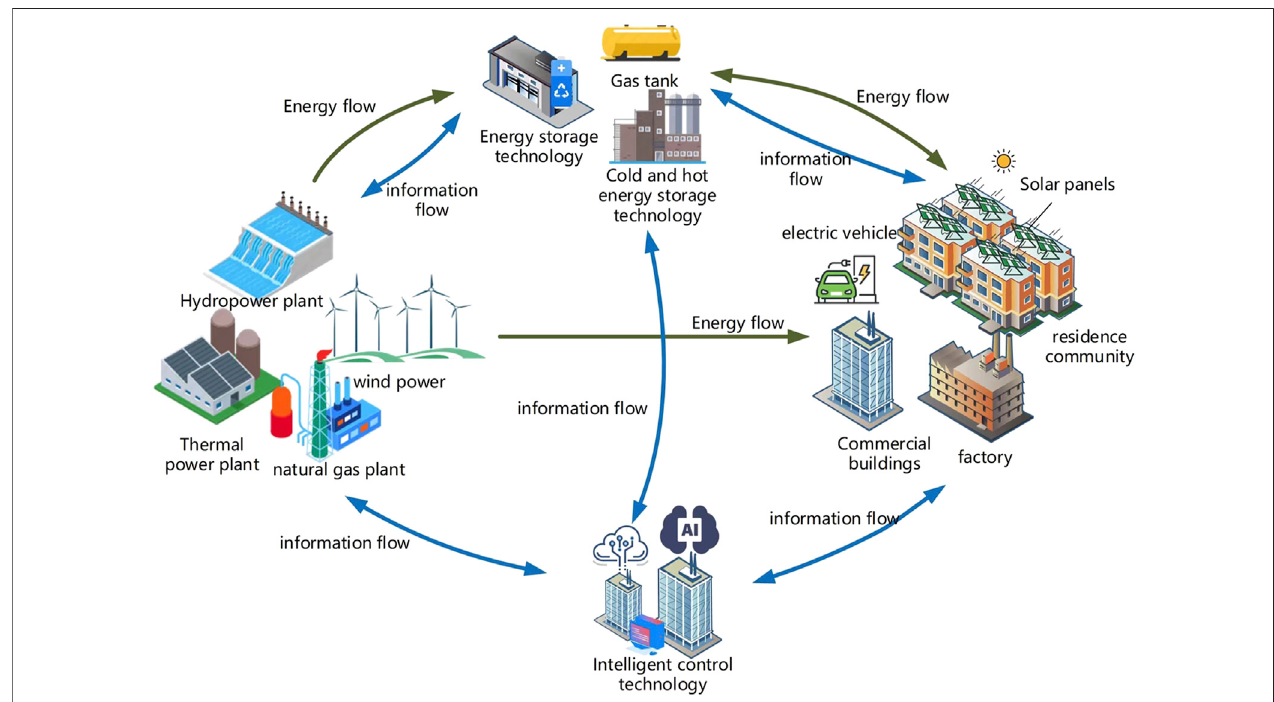
FIGURE 1 | Integrated energy